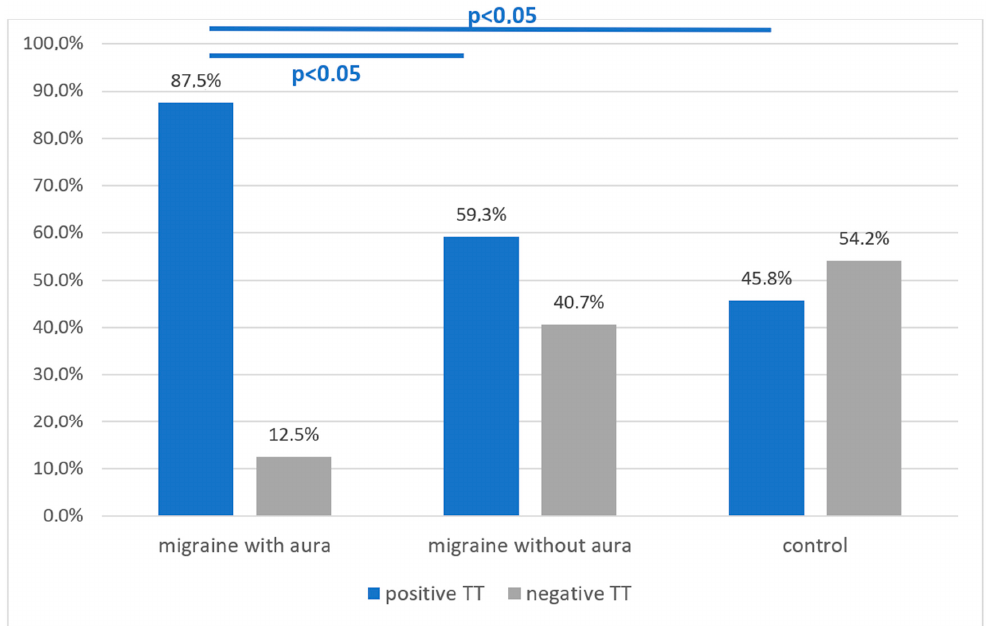
Figure 4. Comparison of the results of the tetany test in the migraine with aura ( n = 8), migraine without aura ( n = 23) subgroup and the control group ( n = 24). A statistically significant difference was found in the migraine subgroup with aura ( p < 0.05).